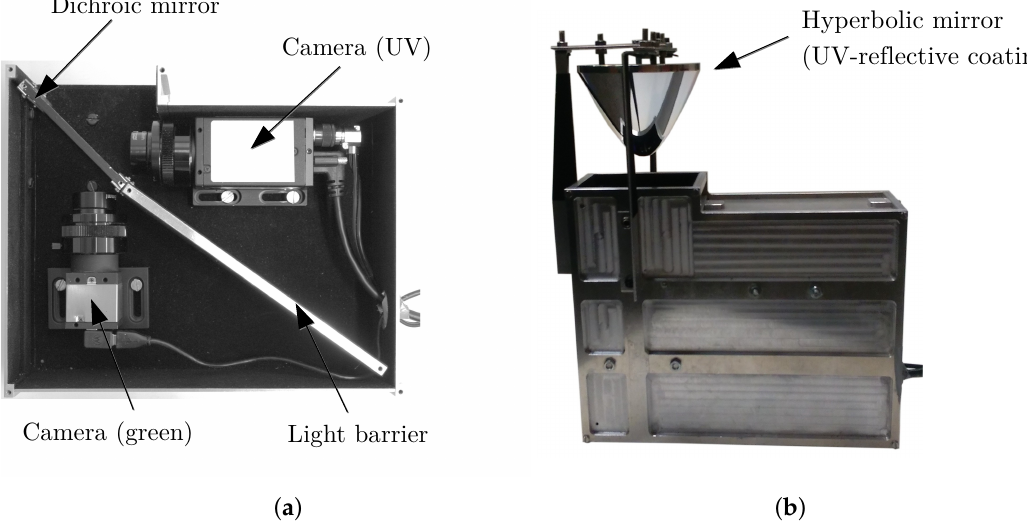
Figure 3. ( a ) The experimental setup (cover-plate removed) with two cameras recording the UV- and green-channel simultaneously; from [19]. ( b ) To capture panoramic images, a hyperbolic mirror can be mounted. The mirror has a reflective (aluminum) and a protective layer (magnesium fluoride) to provide a nearly constant reflection over a wide range of wavelengths (including UV and visible